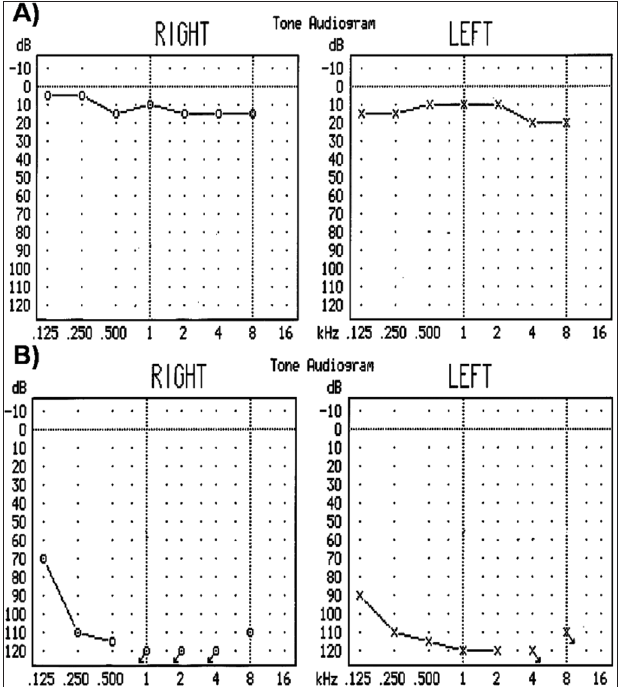
Figure 1. Audiograms - analysis of the 12S rRNA gene - Audiograms of subjects analyzed in the 12S rRNA gene. (A) Healthy individual without audiometric alterations and (B) Patient with hearing loss.